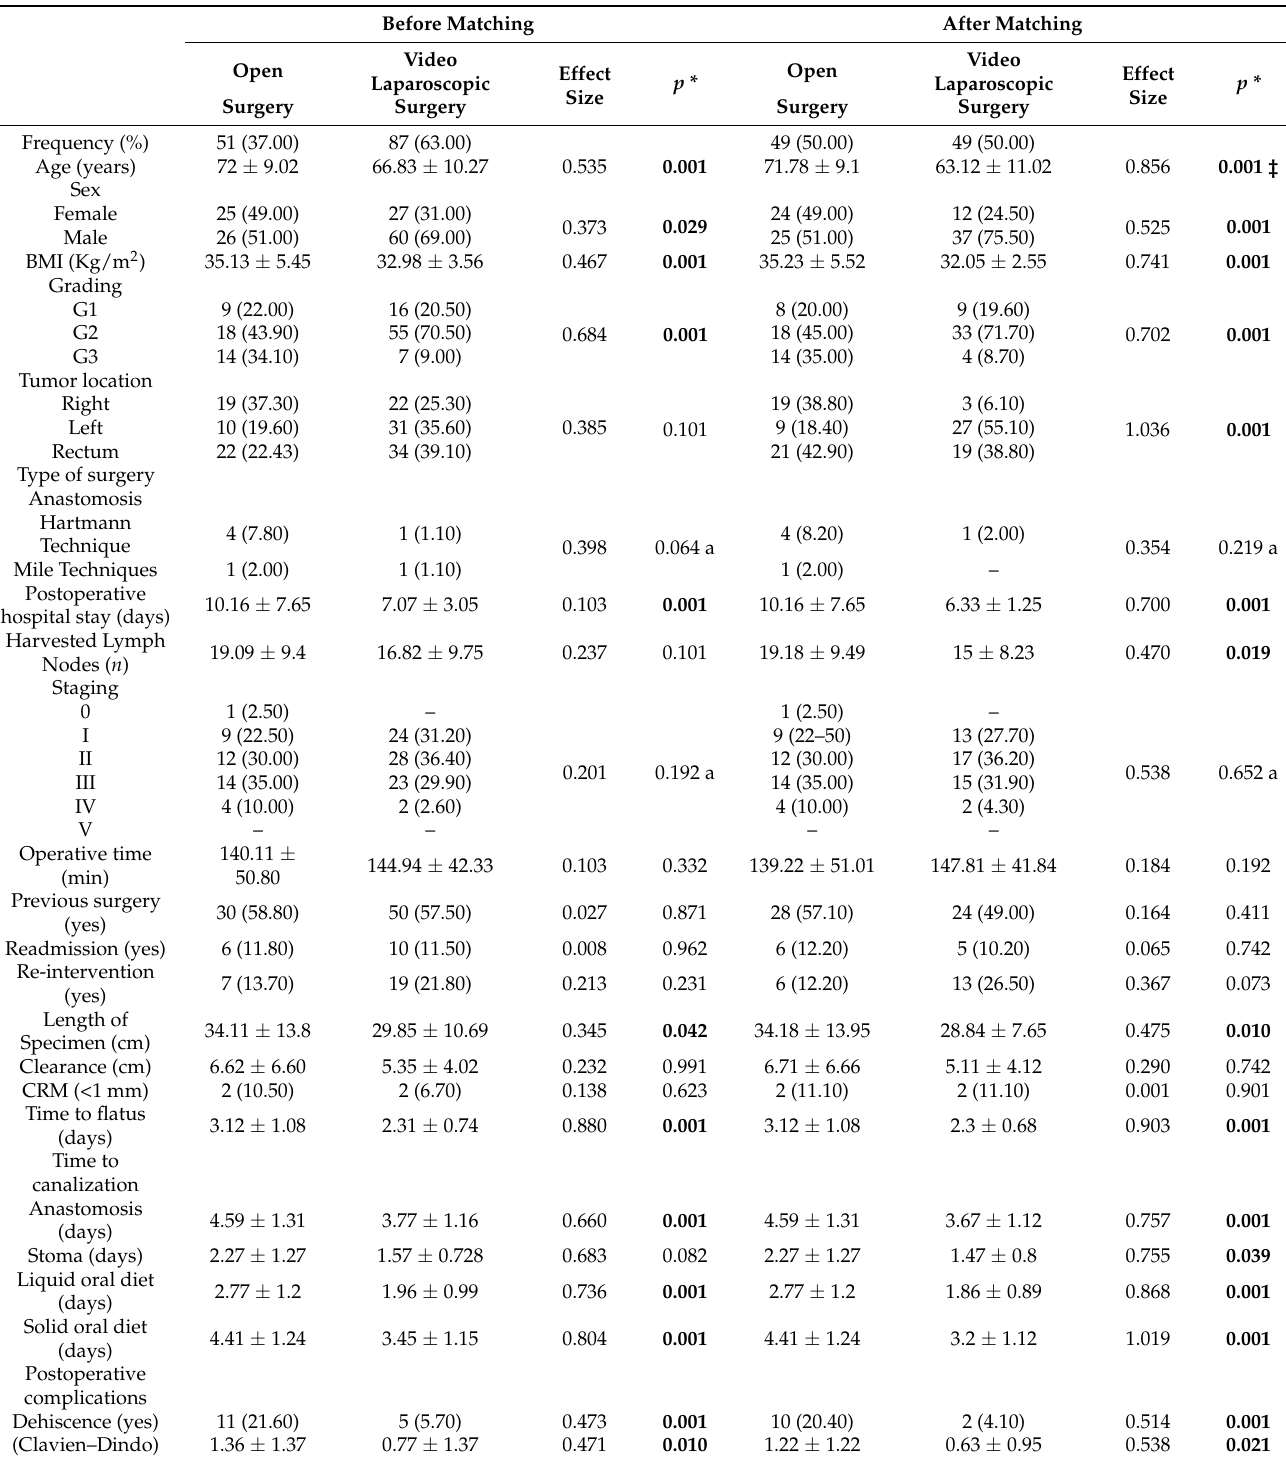
Table 1. Baseline characteristics for patients before and after propensity score matching. Data are shown as mean ± SD continuous variables and as (%) for proportions. Before Matching After Matching Video Video Open Open Effect Effect p * p *Laparoscopic Laparoscopic Size Size Surgery Surgery Surgery